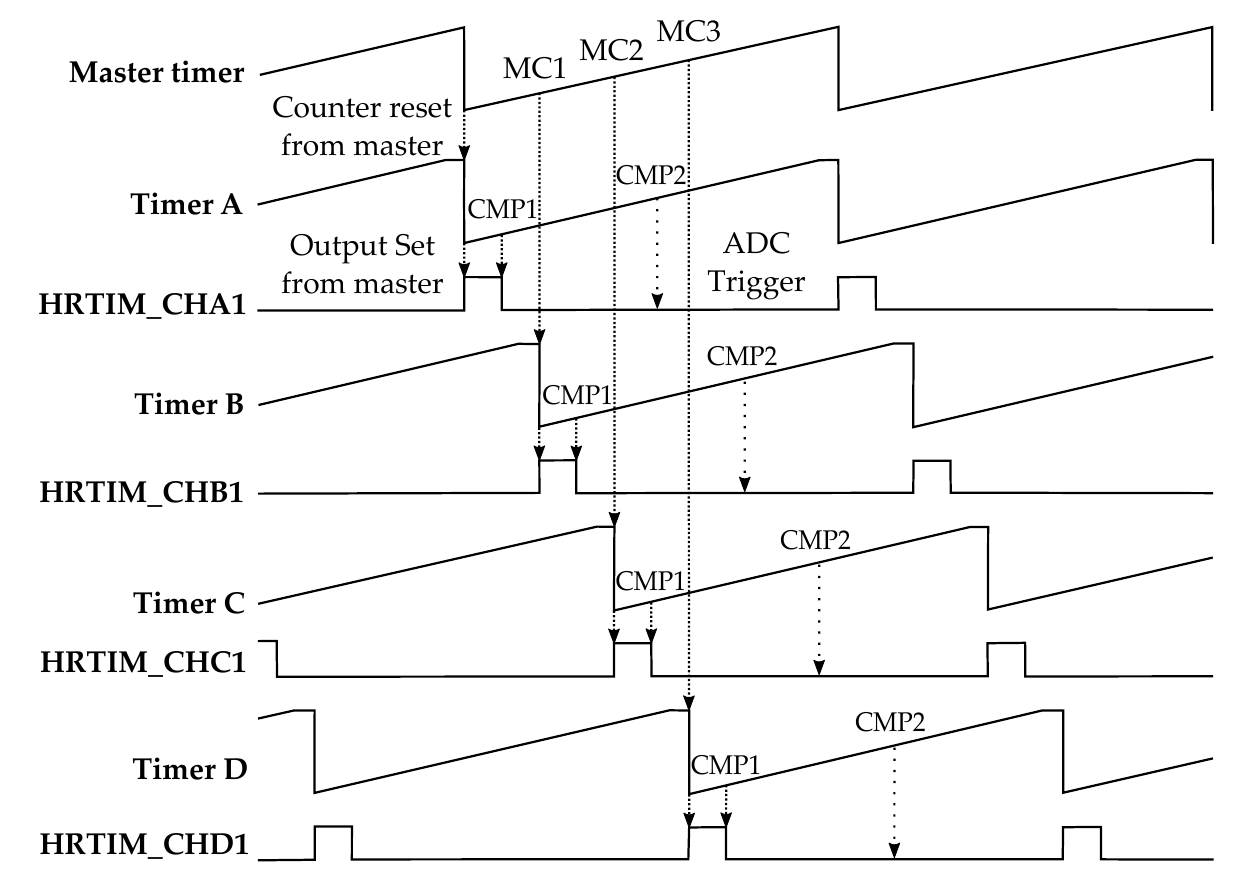
Figure 10. Timing diagram of PWM generation for 4 phases using high resolution